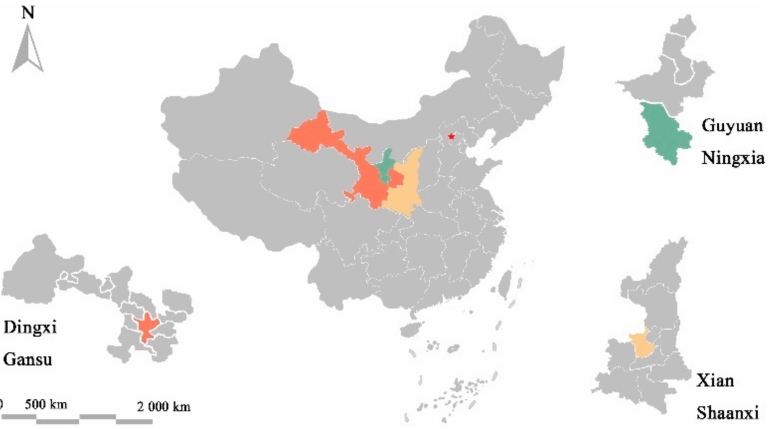
Figure 2. Sample distribution